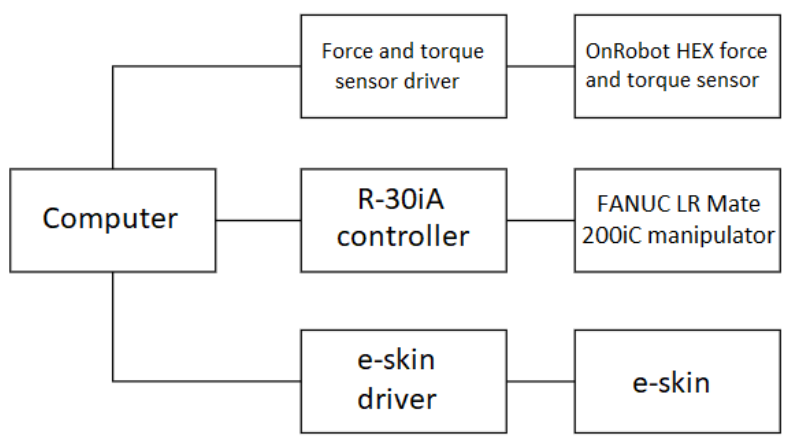
Figure 4. Block diagram of the system used in the measurements. E-skin describes FSR matrix from Figure 2; e-skin driver describes the rest of the electronic system from Figure